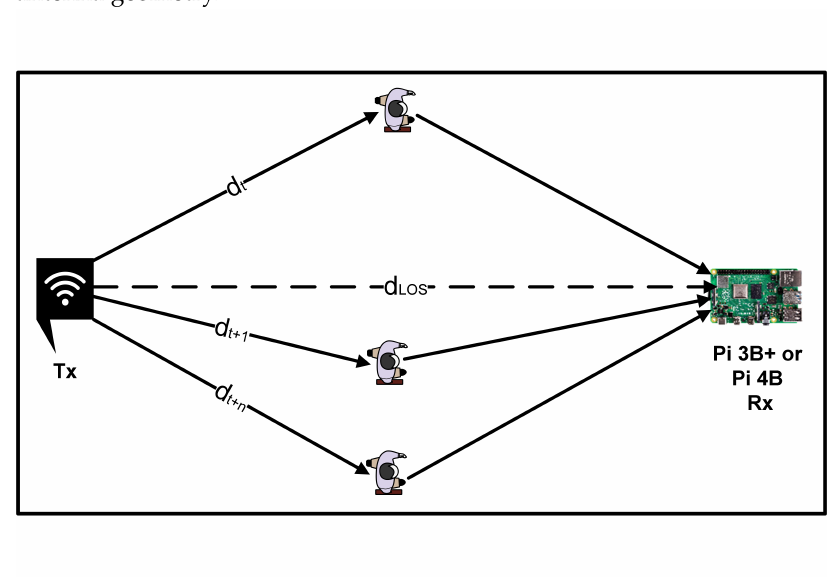
Figure 3. Human activities and effect on Wi-Fi signals